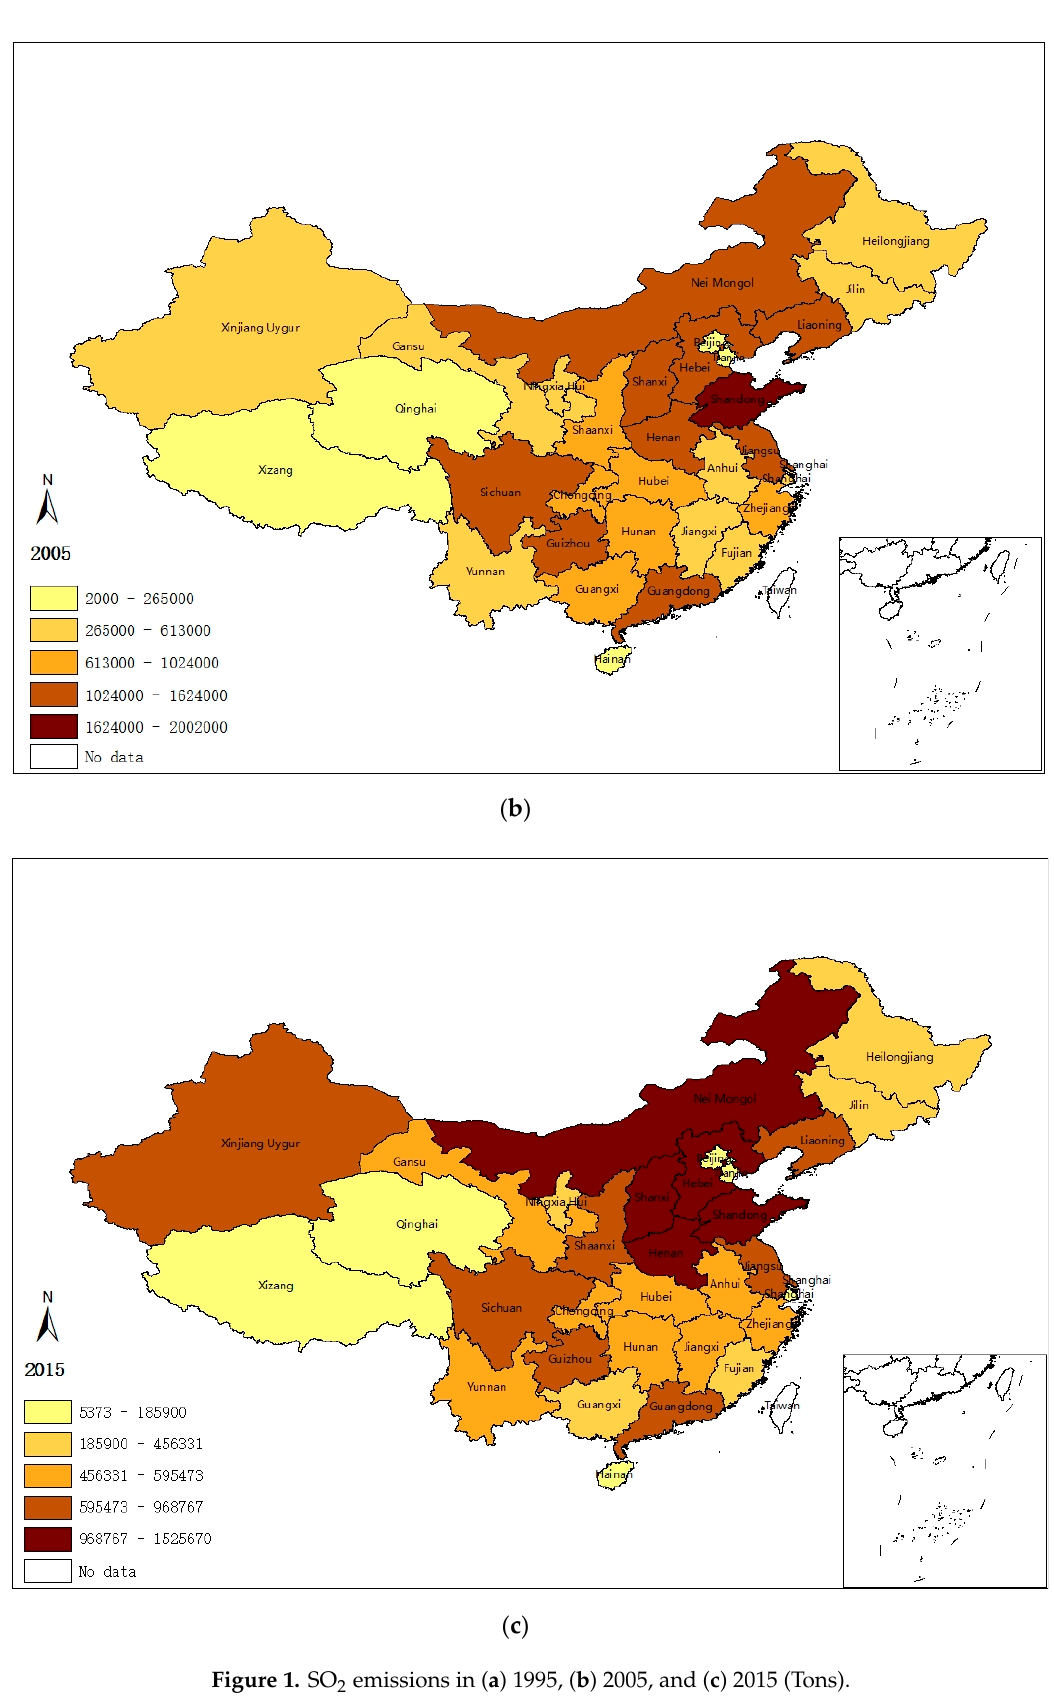
Figure 1. SO 2 emissions in ( a ) 1995, ( b ) 2005, and ( c ) 2015 (Tons).